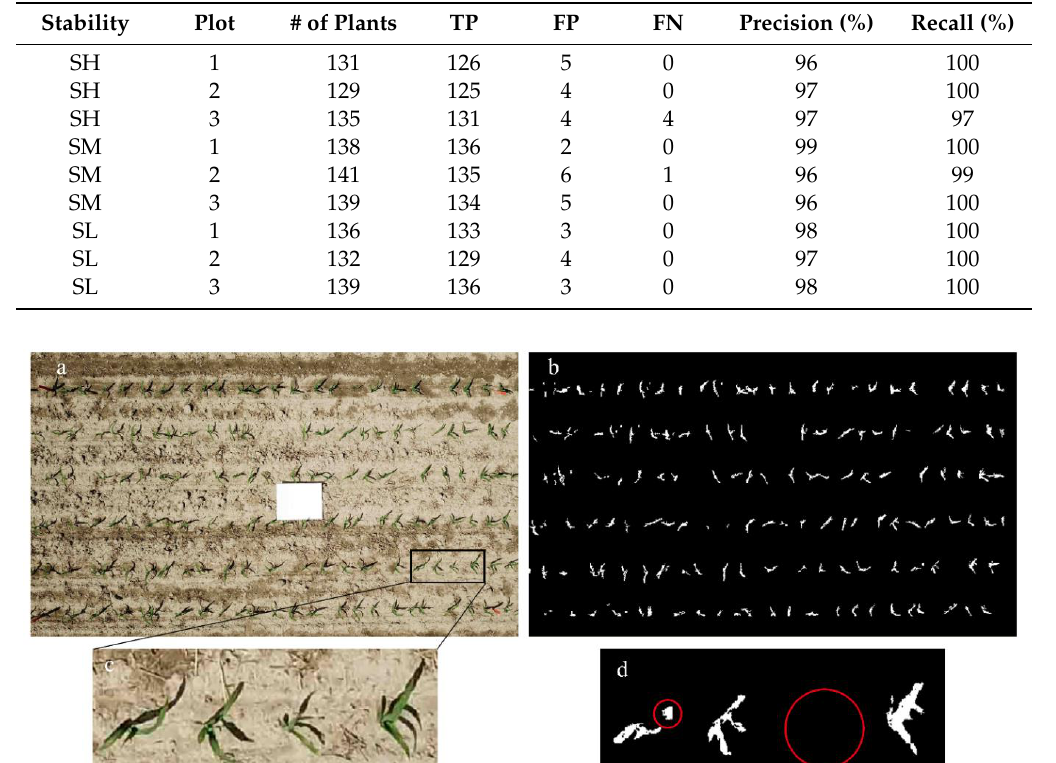
Table 1. Results of maize plant identification with its associated accuracy.